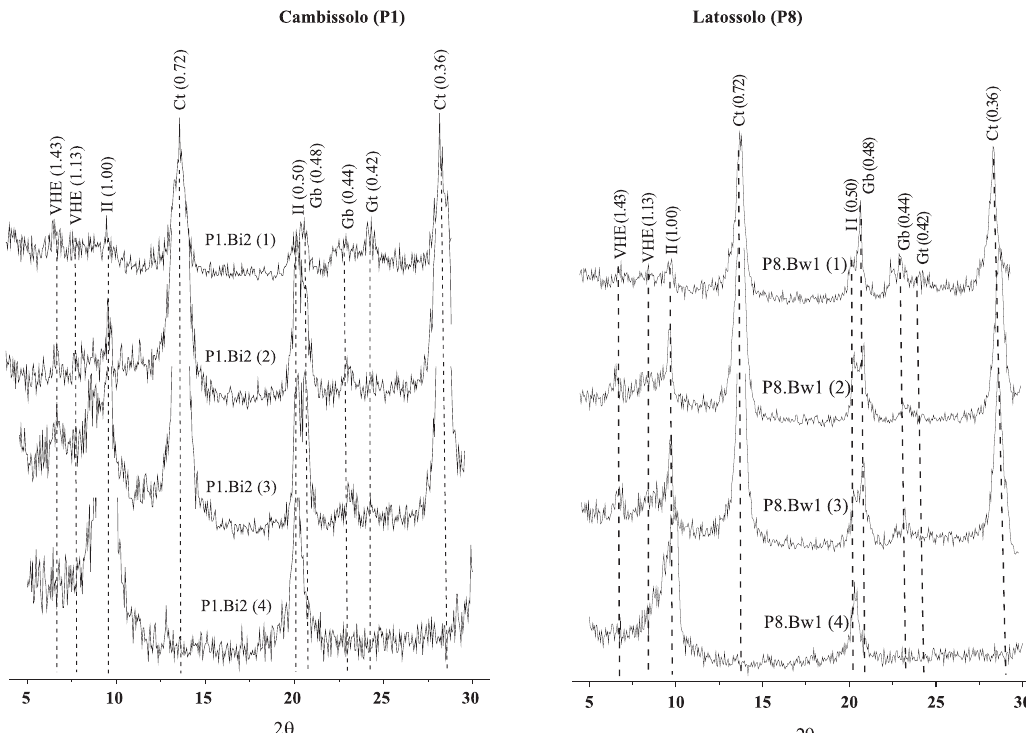
Figura 3. DRX representativos dos tratamentos realizados na fração argila dos solos estudados. VHE: vermiculita com Al-hidroxi entrecamadas; Il: ilita; Ct: caulinita; Gb: gibbsita; Gt: goethita. (1) argila natural; (2) desferrificação com DCB; (3) saturação com KCl; (4) aquecimento a 550